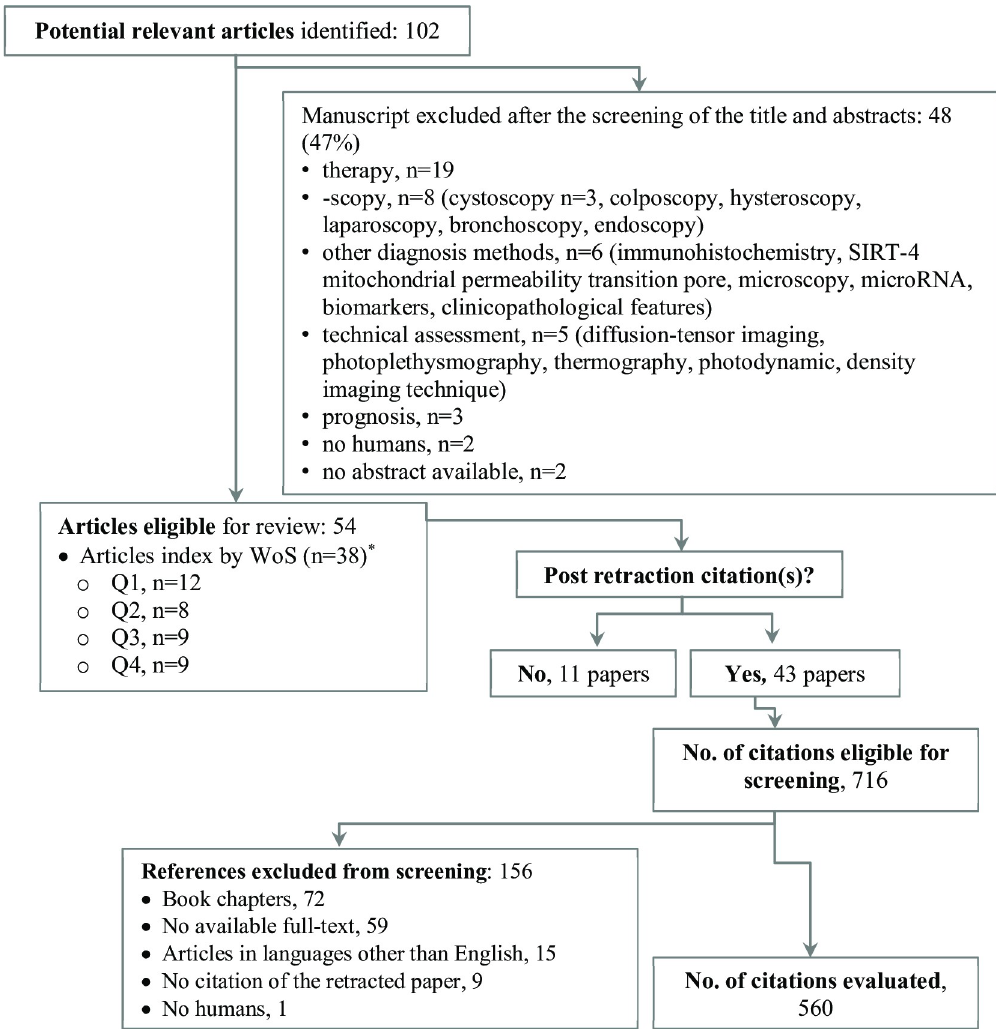
Fig 1. Flowchart of screened manuscripts and reason for exclusion. The search included only studies with an available abstract on PubMed or on the web page of the journal. � The retracted articles indexed by WoS were published in journals classified into the following domains: Radiology , Nuclear Medicine & Medical Imaging (11 articles), Peripheral Vascular Disease , Clinical Neurology , Cardiac & Cardivascular Systems (each with 4 articles), Medicine , General & Internal (3 articles), and Urology & Nephrology (2 articles). All other WoS domains had one retraction ( Anesthesiology , Dentistry , Oral Surgery & Medicine , Emergency Medicine , Endocrinology & Metabolism , Mathematical & Computational Biology , Ophthalmology , Orthopedics , Pathology , Pediatrics , Surgery